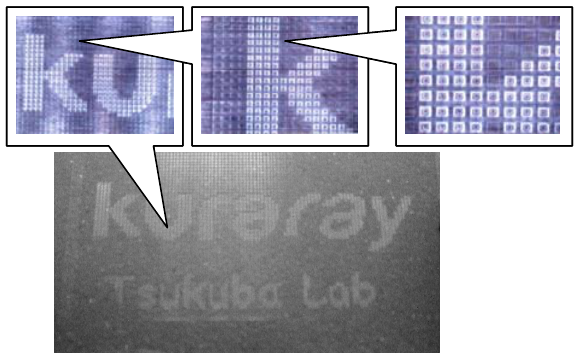
Figure 8. The image of enlarged image of electrochromic display